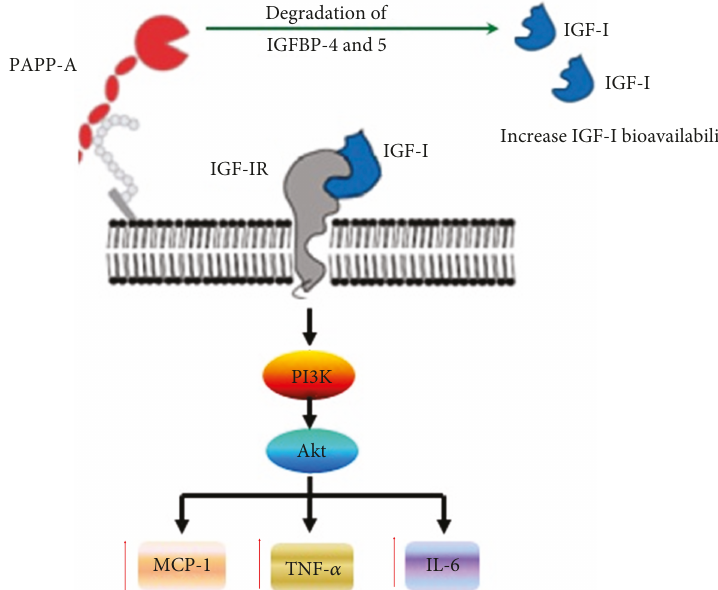
Figure 5: Schematic representation of the induction of MCP-1, TNF- α , and IL-6 expressions by PAPP-A through the IGF-I/PI3K/Akt pathways in RAW264.7